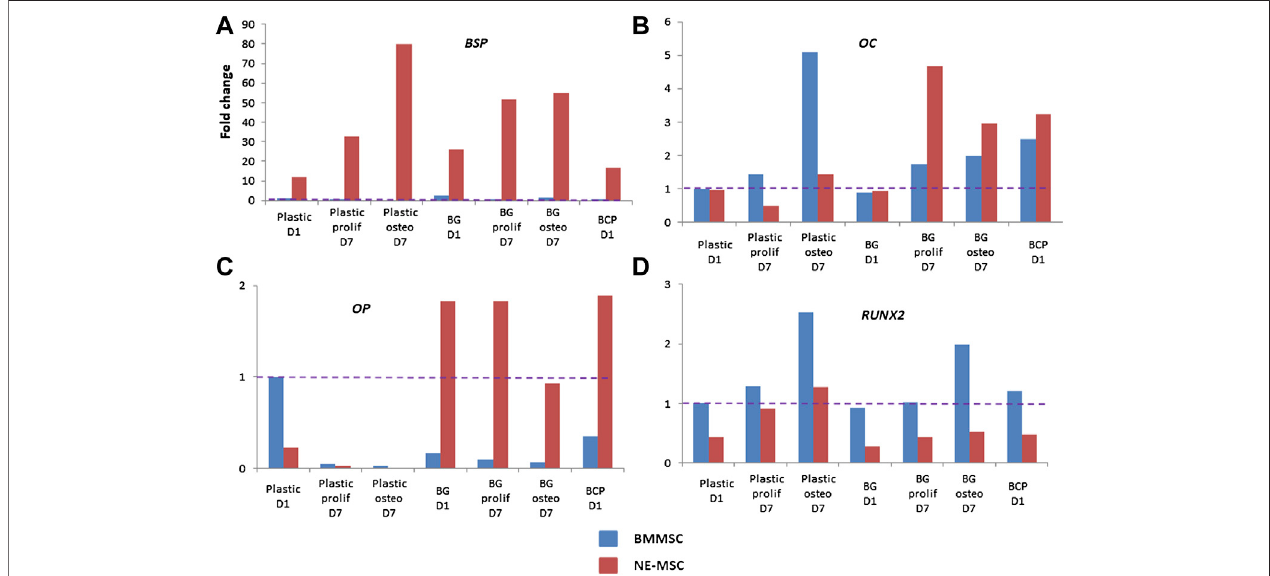
FIGURE7| Comparativeexpressionofossi fi cation-relatedgenes.UsingRTqPCR,theexpressionof RUNX2 , BSP , COL1A1 , OC , BMP2 , BMP4 , ALP ,and OP was measuredforeachcelltypeonplastic,BGandBCPbiomaterials.OnBGbiomaterial,NE-MSCsoverexpressthegenescodingforBSP,OCandOP (A – C) andBMMSCs the gene coding for RUNX2 (D) .